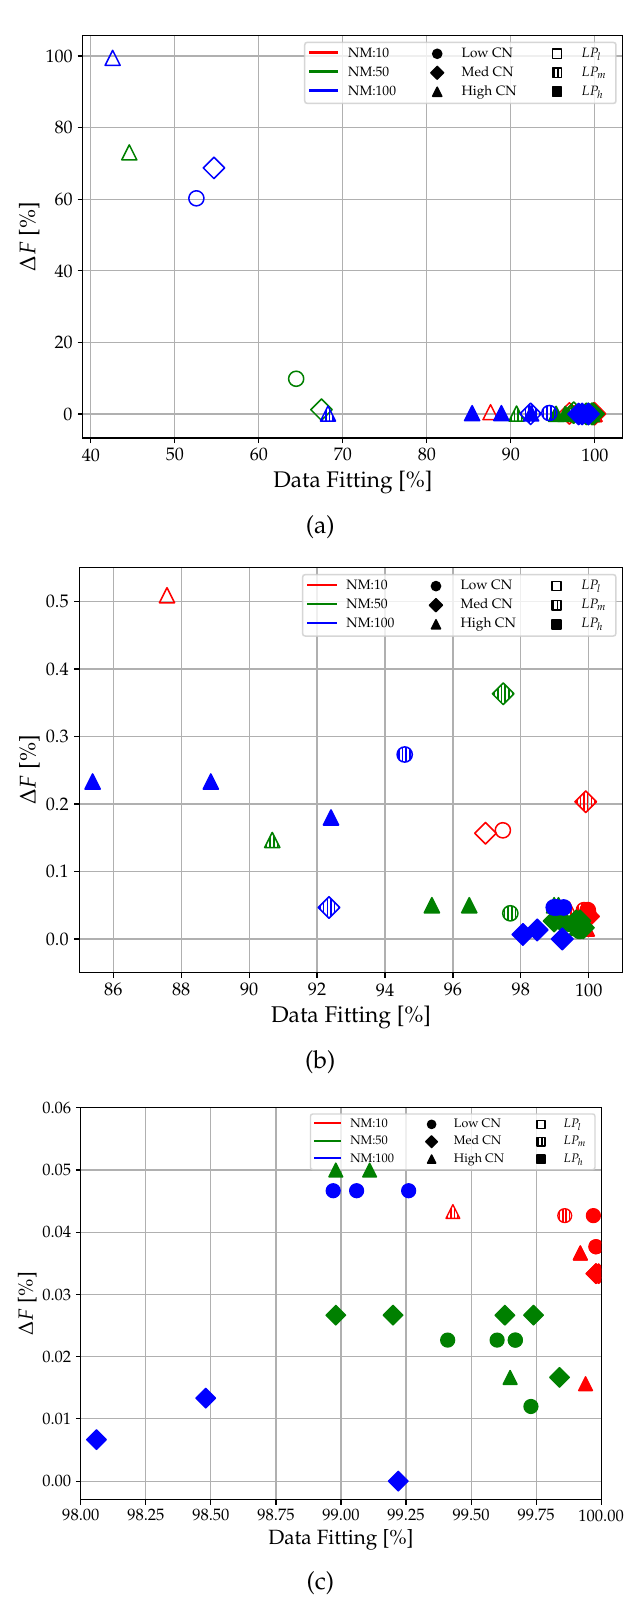
Figure 17. Correlation between the data fitting and the ∆ F scatter: the data are related to NM, CN, and LP. Different zoom levels of data fitting are proposed in order to highlight different details: (a)